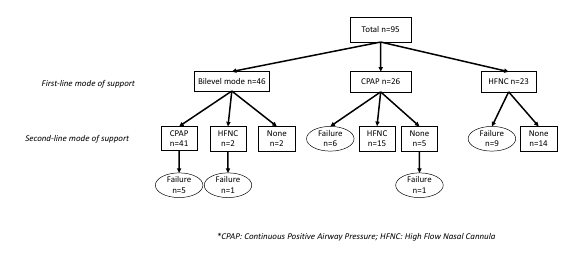
Fig. 1 Bar plots of macro‑ and microcirculation‑parameters’ trends dur‑ ing a progressive increment of either the dobutamine dose or the ECMO flow. The point corresponds to the median, the T‑bars represent the 25th and 75th percentile, p shows the effect of a progressive increment of either the dobutamine or the ECMO flow